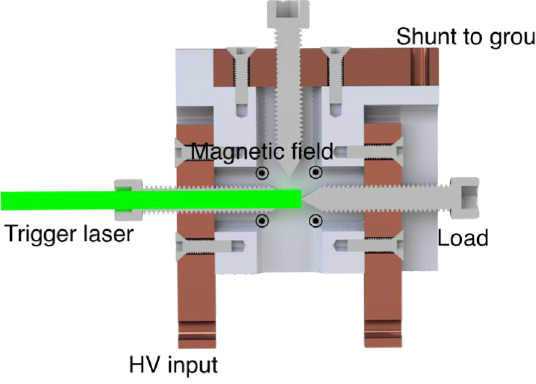
Figure 4. Cross section of a plasma switch.